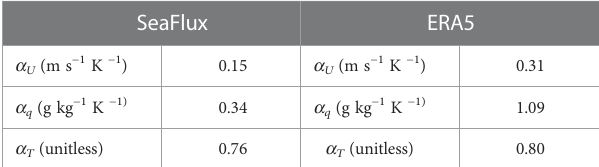
TABLE 4 As in Tables 2 and 3 but for the